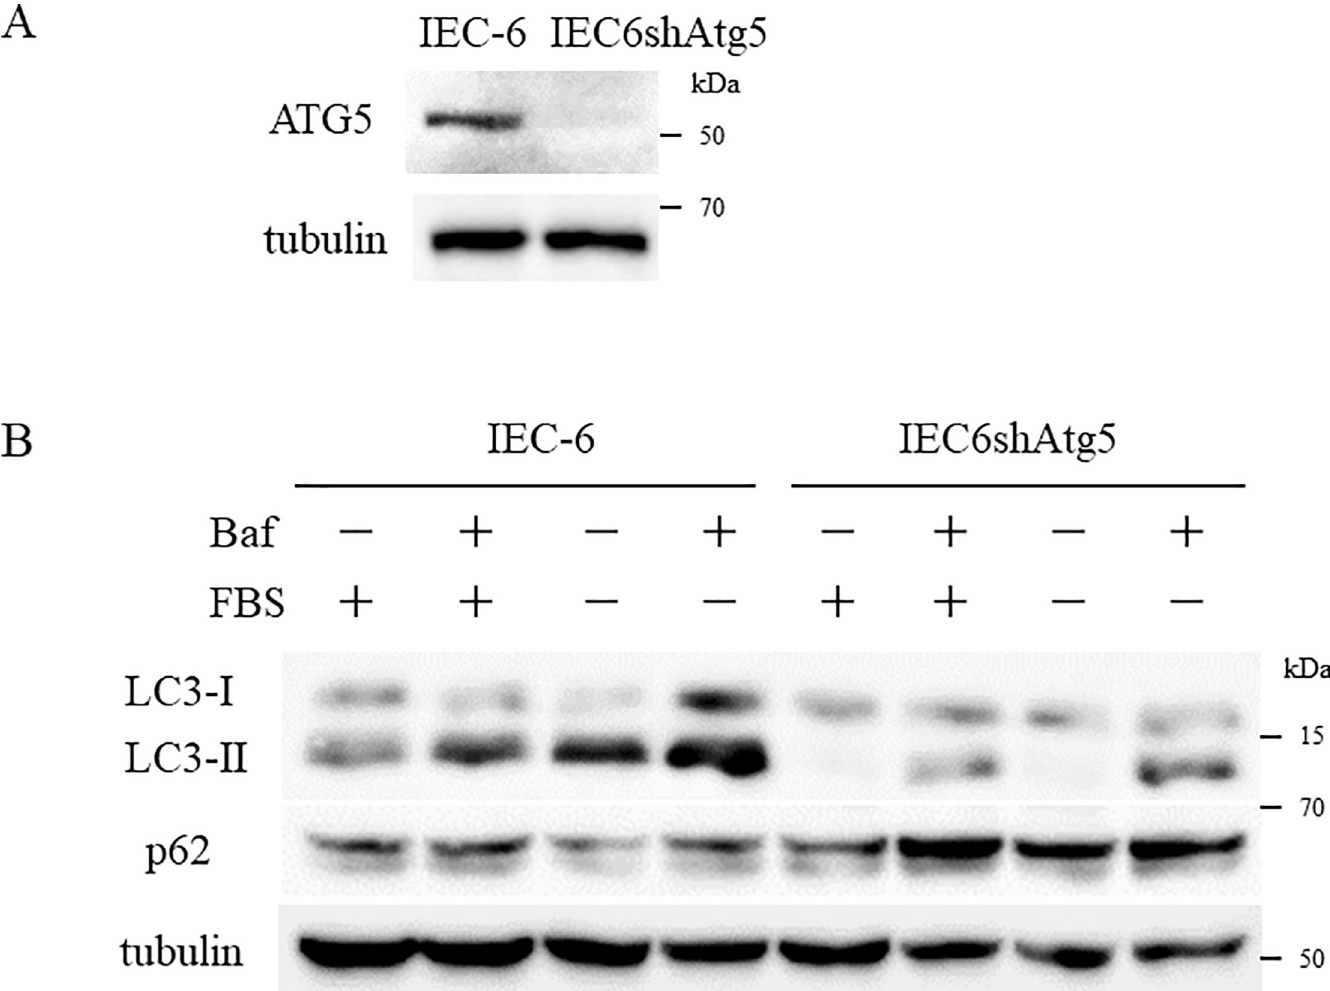
Fig 2. The autophagic flux is normal in IEC-6 cells but atg5-silencing inhibits autophagy. (A) LC3 expression levels in IEC-6 and IEC6shAtg5 cells were determined using Western blot analysis. IEC-6 cells were cultured in a standard culture medium or in a serum-free culture medium for 24 h. (B) LC3 expression levels in IEC-6 cells with or without Bafilomycin A1 (Baf) for 24 h were determined to confirm the presence of autophagic